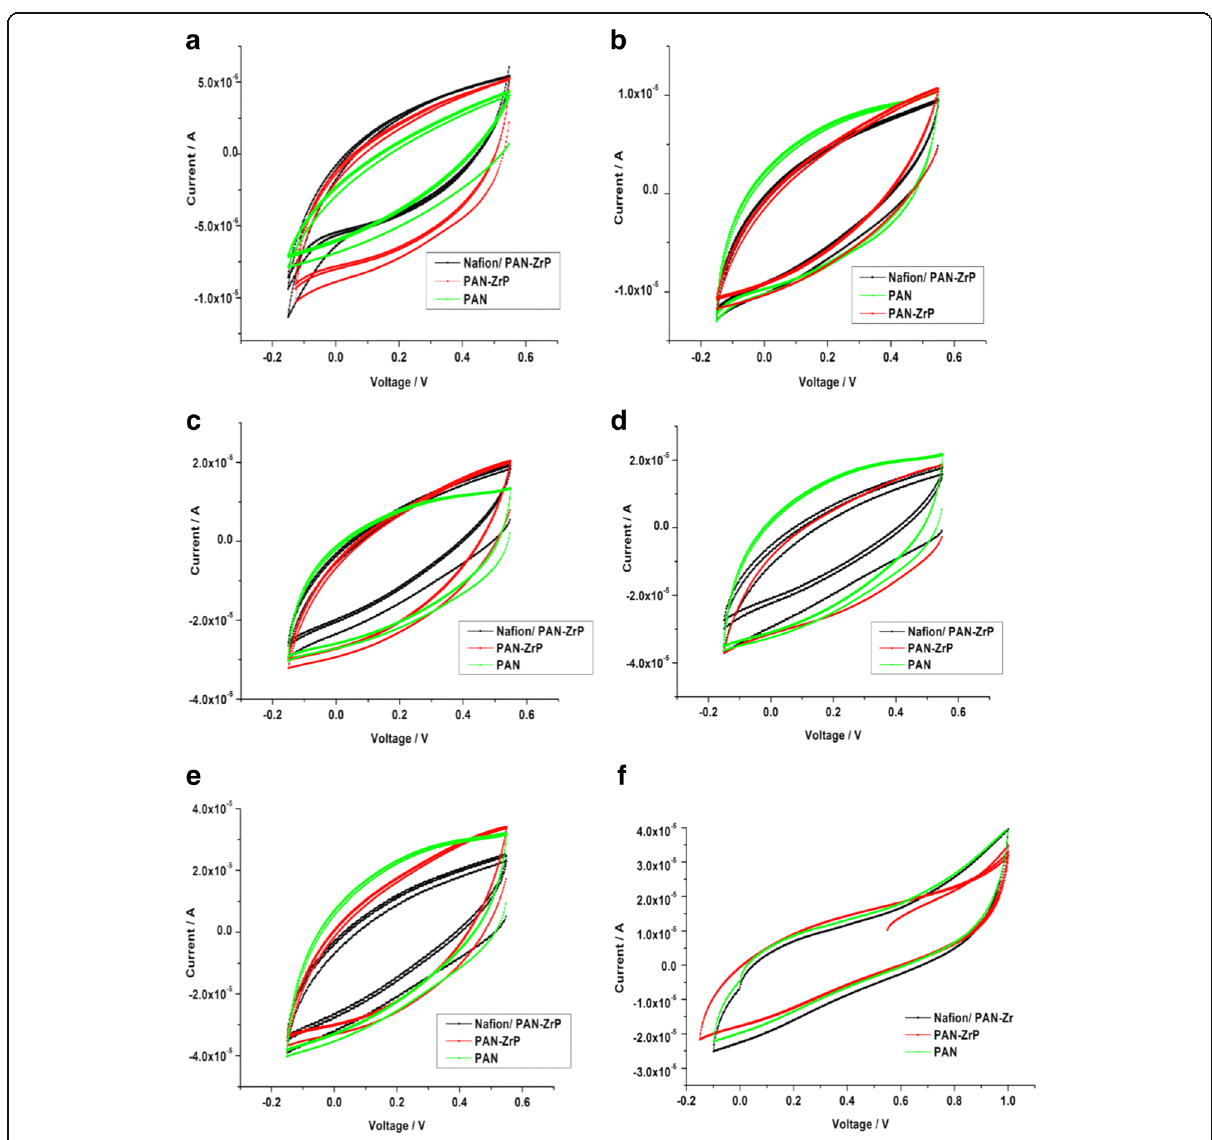
Fig. 7 Cyclic voltammogrammes of PAN, PAN/ZrP and PAN-Nafion/ZrP nanofibres at a 10mVs − 1 , b 20mVs − 1 , c 30mVs − 1 , d 50mVs − 1 , e 100mVs − 1 and f 100mVs − 1 and CV test ranging from − 0.15 to